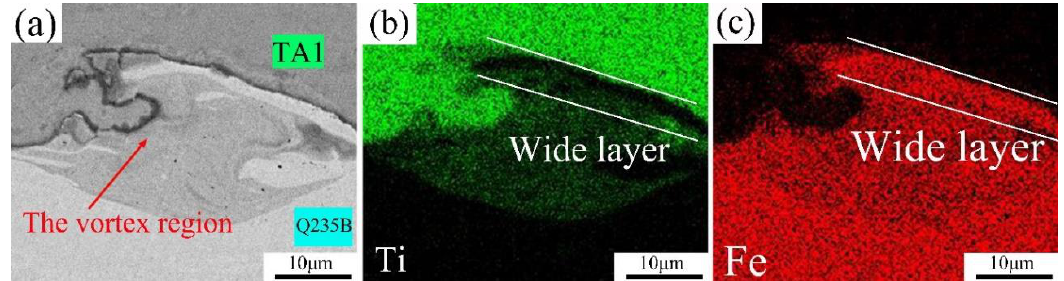
Figure 4. ( a ) SEM microstructure of melted vortex regions of TA1/Q235B welded plate ( b ) EDS map for Ti (Green) and ( c ) Fe (Red).